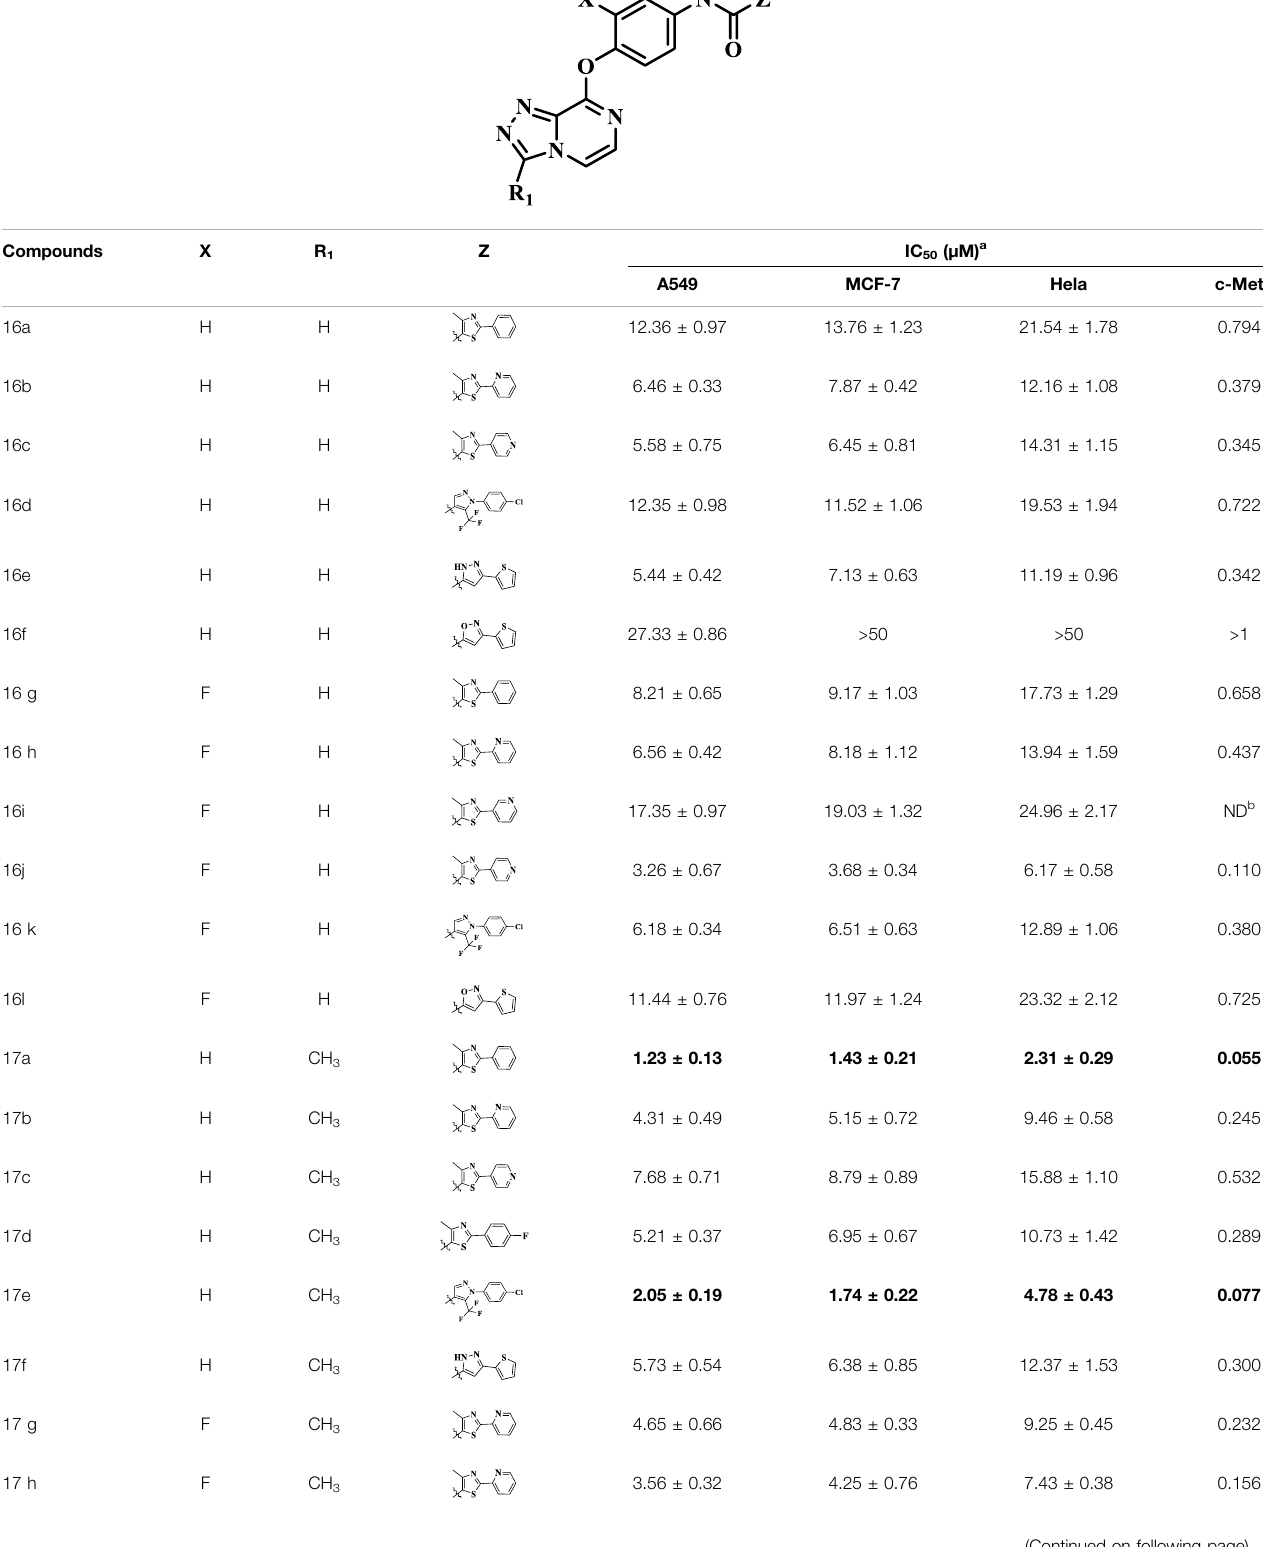
TABLE 1 | Antiproliferative and mesenchymal – epithelial transition factor (c-Met) kinase inhibitory activities of the target compounds.